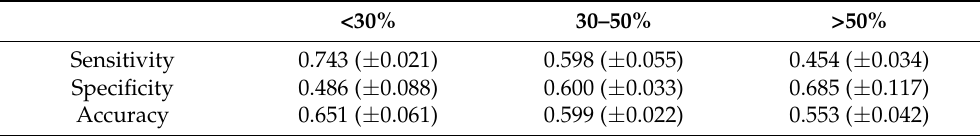
Table 10. Mean ± standard deviation of model performance parameters for the respective number of cross-validations among the overall farm-based split under consideration of a low (<30%), medium (30–50%), and high (>50%) lameness incidence risk including animal and farm data, AMS data, and sensor records.